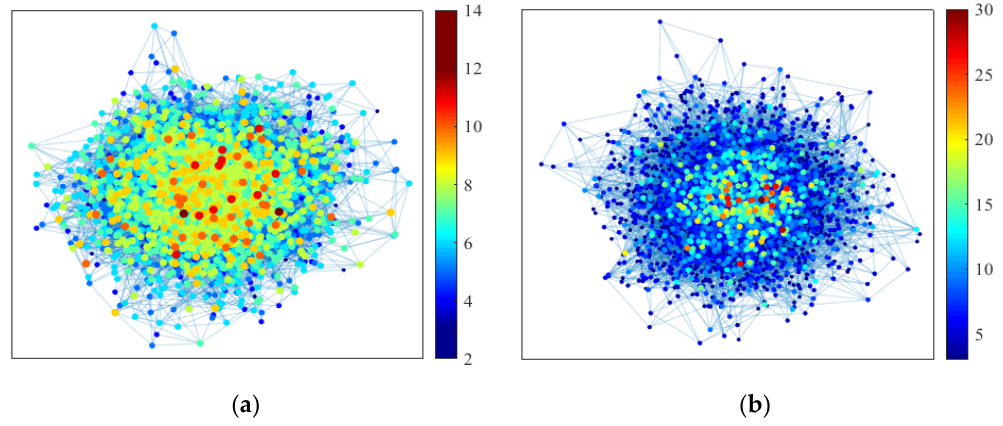
Figure 2. ( a ) WS small-world network structure; ( b ) BA scale-free network structure.